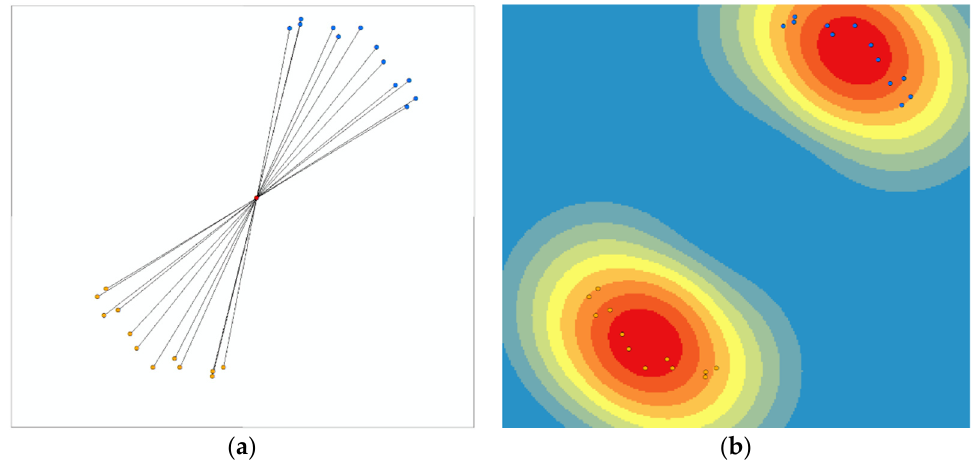
Figure 14. ( a ) OD flows and ( b ) kernel density distribution of OD points in vector space.